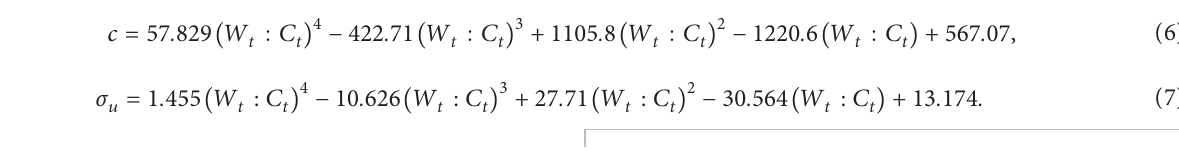
− w curve. (b) q − W : C u u